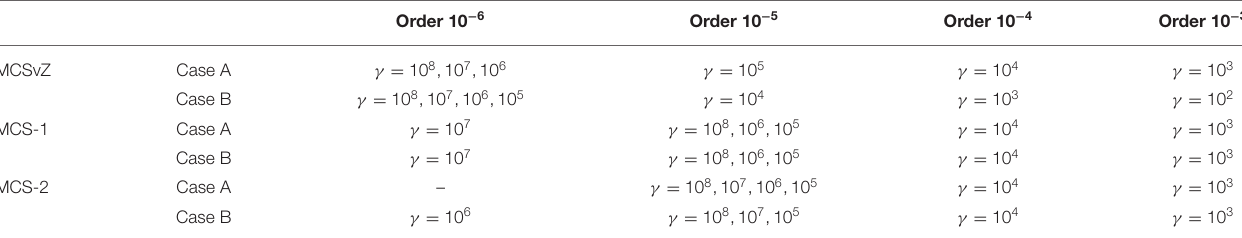
TABLE 2 | Relation between position-error order and parameter γ in simulations based on planar manipulator using different control schemes in case A and case